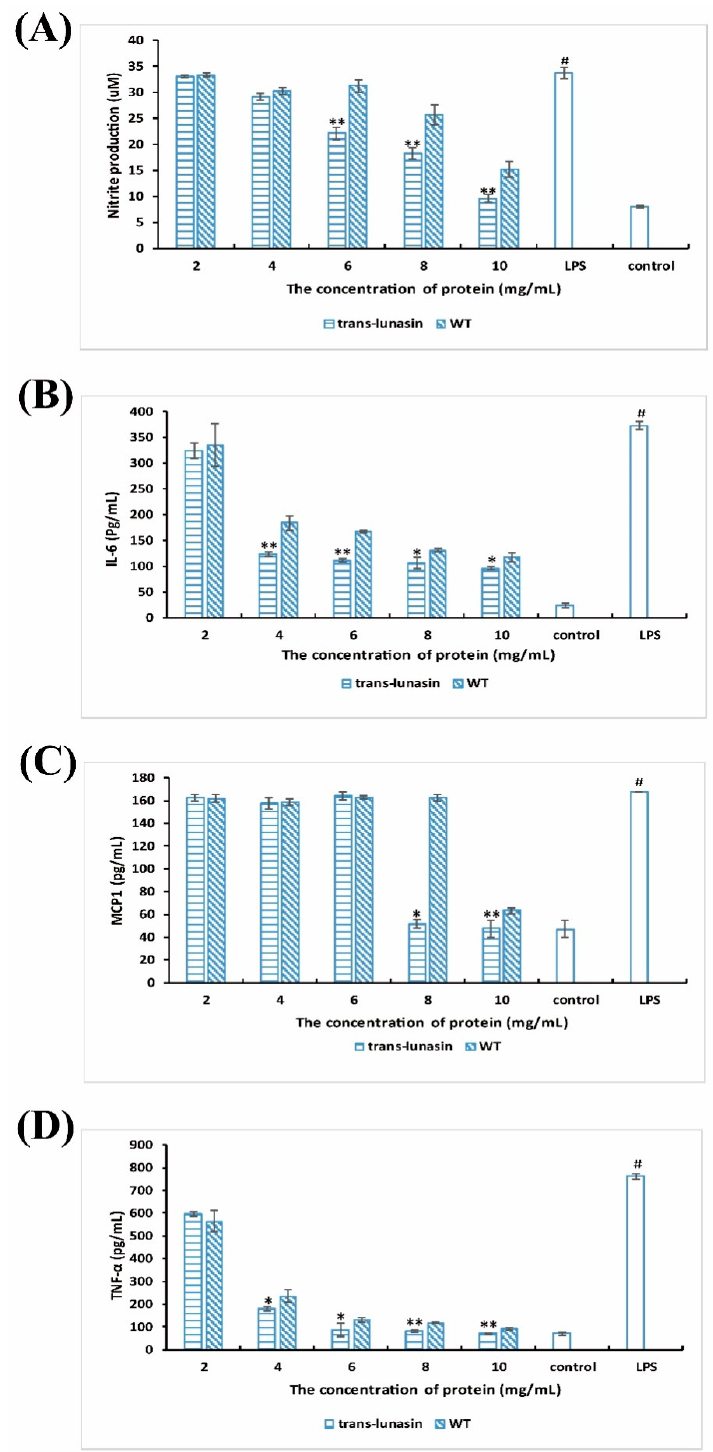
Figure 6. Anti-inflammatory activity analysis of the rice peptide extracts. The production of NO ( A ) and the release of pro-inflammatory cytokines including IL-6 ( B ), MCP1 ( C ), and TNF- α ( D ) in RAW264.7 cells were inhibited by the rice peptide extracts. Data are shown as the means of three independent experiments, the bars indicate ± SD. * p < 0.05 and ** p < 0.01 shows significant differences between the trans-lunasin rice and wild type rice, # p < 0.01 shows significant differences between the LPS-alone treated group and the vehicle control group.